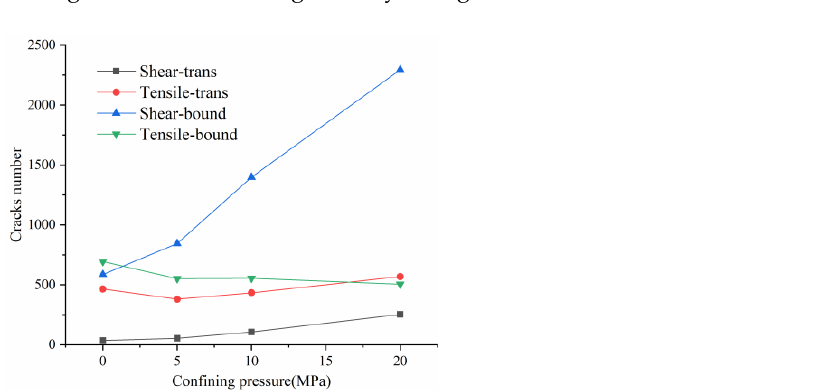
Figure 19. The quantitative variation of tensile/shear cracks on grain boundary and intracrystalline under different confining pressures at peak strength.